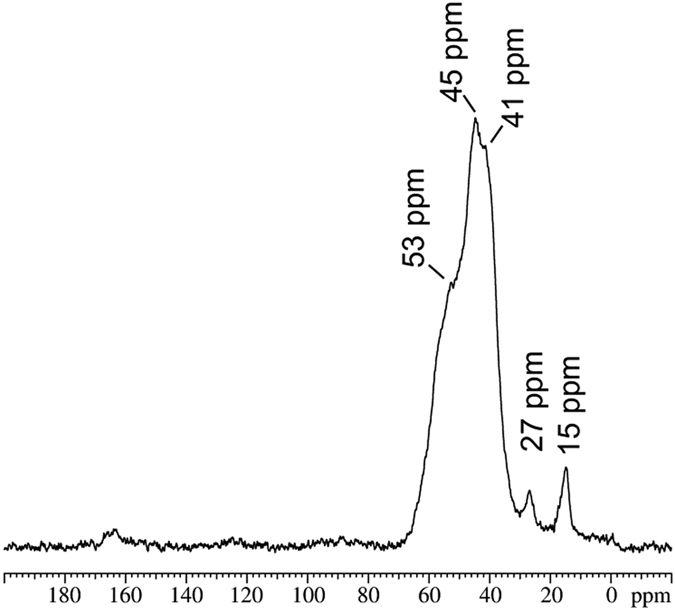
13C CP{1H}/MAS NMR spectrum (9.4 T, 4.0 kHz spinning speed) of pristine Sn3S7(trenH)2.